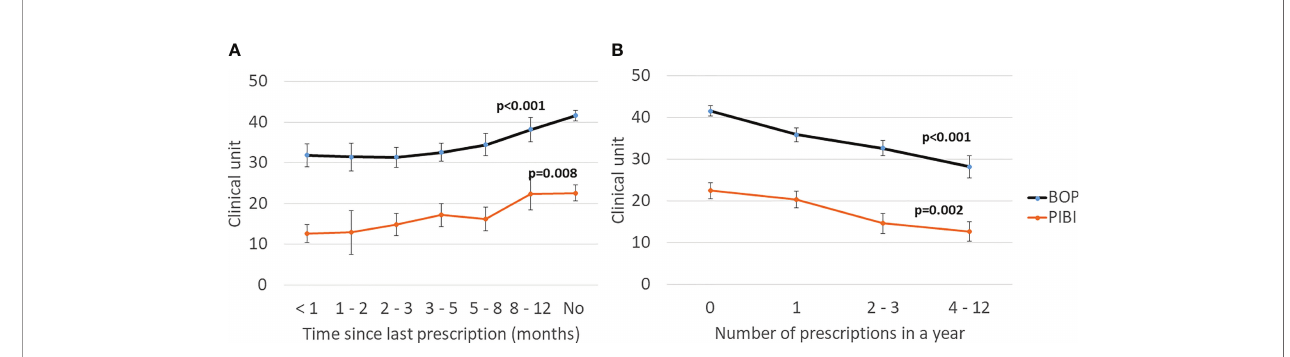
FIGURE 2 | Effect of antibiotics on clinical periodontal parameters. (A) Time since the last prescription. (B) Number of prescriptions during the preceding year. Mean values with the SE are shown. Bleeding on probing (BOP) is the percentage of bleeding sites from all examined sites. Periodontal in fl ammatory burden index (PIBI) is the number of deepened periodontal pockets: PPD ≥ 4 mm + 2 × PPD ≥ 6 mm. The p-values are for the weighted linear terms from Anova for